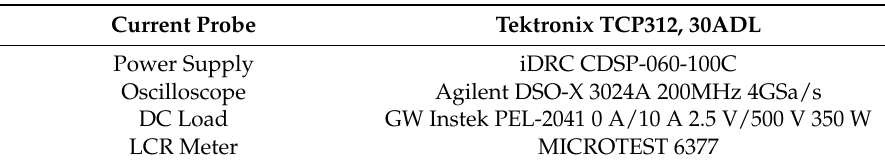
Table 2. Measurement Equipment.